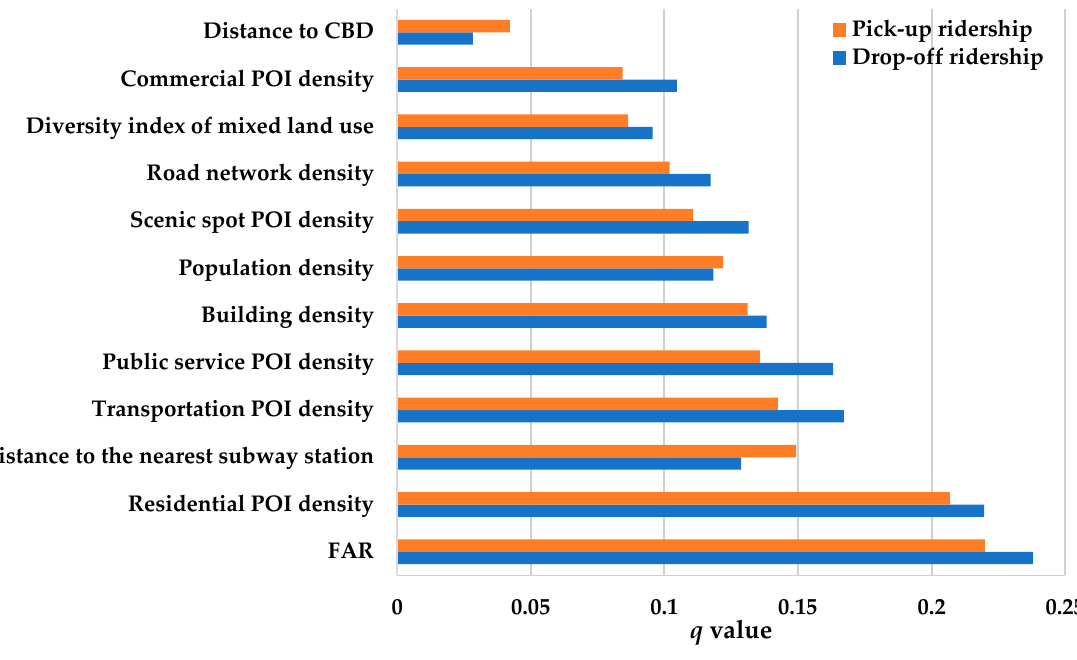
Figure 9. Contribution of single explanatory variables on pick-up and drop-off ridership in the evening peak hours by the factor detector.